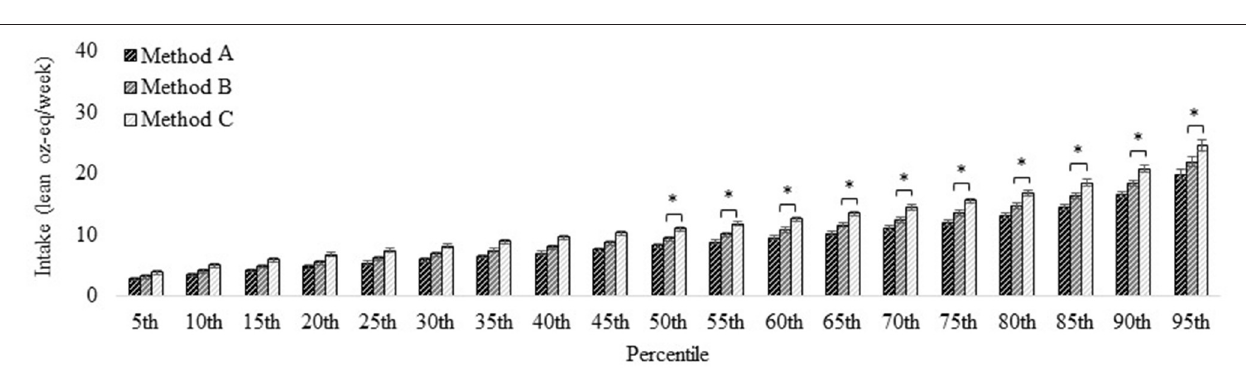
FIGURE 3 | Distribution of poultry intake for the U.S. population aged ≥ 2 years estimated via different methods. Method A: Unprocessed poultry, includes chicken, turkey, Cornish hens, duck, goose, quail, and pheasant (game birds); excludes organ meat and cured meat; additionally excludes chicken patties, nuggets, and tenders. Method B: Unprocessed poultry, includes chicken, turkey, Cornish hens, duck, goose, quail, and pheasant (game birds); excludes organ meat and cured meat and includes chicken patties, nuggets, and tenders. Method C (reference): Total poultry, includes unprocessed poultry, processed poultry, and chicken patties, nuggets, and tenders. See Figure 1 for further descriptions of each method. Results are shown as mean ± SEM within each percentile estimated via the NCI Method for usual dietary intakes. *Difference from Method 1 estimate (effect size) is ≥ 3.0 oz-eq per week. Data source: US Centers for Disease Control and Prevention/National Center for Health Statistics, NHANES 2015–2018, day 1 and 2 dietary recall